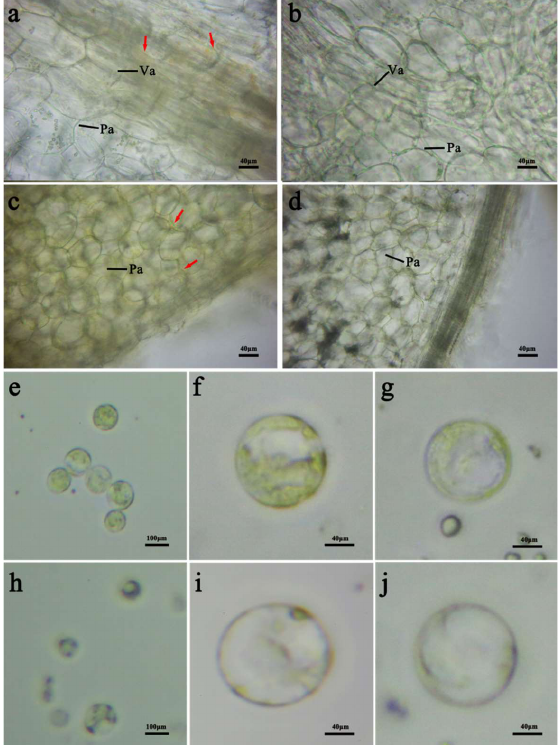
Figure 2. Microstructure of the inner leaves and short stems in the ‘1900262′ and ‘1900264′ lines. Microstructure of the short stem cells in the ‘1900264′ ( a ) and ‘1900262′ lines ( b ). Microstructure of the inner leaf cells in the ‘1900264′ ( c ) and ‘1900262′ lines ( d ). Inner leaf protoplasts of the ‘1900264′ ( e ) and ‘1900262′ lines ( h ) under 10× light microscope. Inner leaf protoplasts of the ‘1900264′ ( f ) and ‘1900262′ lines ( i ) under 40× light microscope. Short stem protoplasts of the ‘1900264′ ( g ) and ‘1900262′ lines ( j ) under 40× light microscope. The point of the red arrow indicates the chromoplasts. Va: vascular bundle; Pa: parenchyma cell.